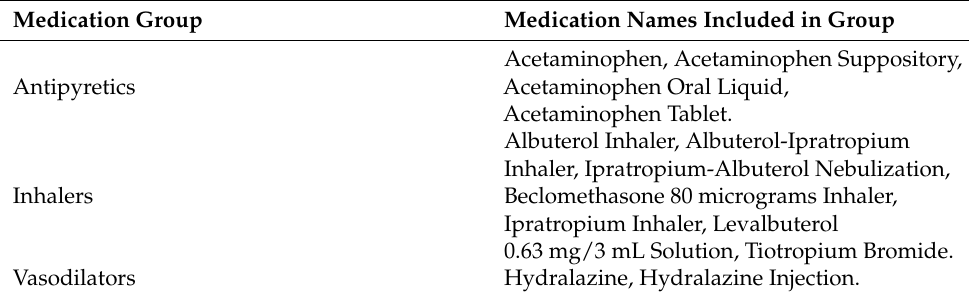
Table 1. Medication names included in each medication